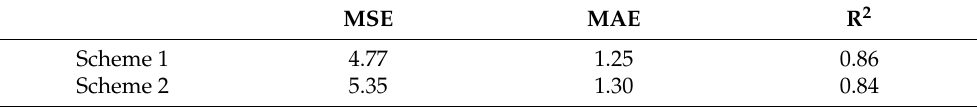
Figure 7. The time series comparison images of the prediction results of the two prediction schemes (Example time 4 May 2020). The first row of images in Figure 7 shows the actual infrared images from the AGRI observation of the FY-4A satellite with a time interval of 15 min. The second and third rows show the visualization results of Scheme 1 and Scheme 2, respectively. The first eight images in each row are the absolute errors between the predicted results and the ground truth. The images are arranged in the temporal order of the prediction and are used to describe the bias of the predicted results compared to the actual observations. The last eight images are the satellite images predicted by the network, arranged in time order, and match the observed data in the first row. According to the results in Figure 6, it can be found that Scheme 1 can better capture long-term variability characteristics. It also pro- vides a better description of cloud motion. Scheme 2 generates a relatively clearer image but does not capture the long-term variability well. We believe that this is because the errors in Scheme 2 are accumulated in each frame of the prediction process, which leads to a certain degree of influence on the long-term prediction results. According to the re- sults in Figure 6, it can be found that Scheme 2 shows good prediction performance in the first two frames of prediction. However, errors gradually accumulate as the prediction proceeds. Scheme 2 cannot capture the long-term change characteristics in the prediction process as well as Scheme 1, which also causes the problem of poor prediction perfor- mance in long-term prediction. The results in Table 2 also illustrate that Scheme 1 is able